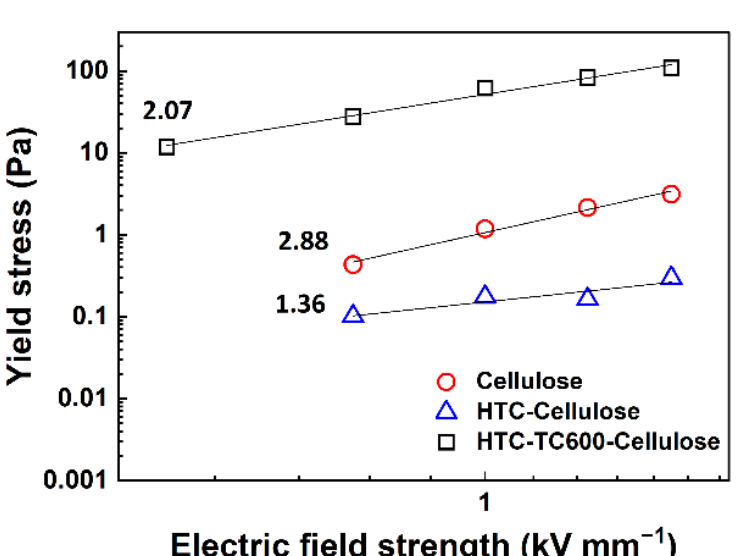
Figure 7. A log–log dependence of yield stress values taken as shear stress at low shear rates on electric field strength for the prepared ER